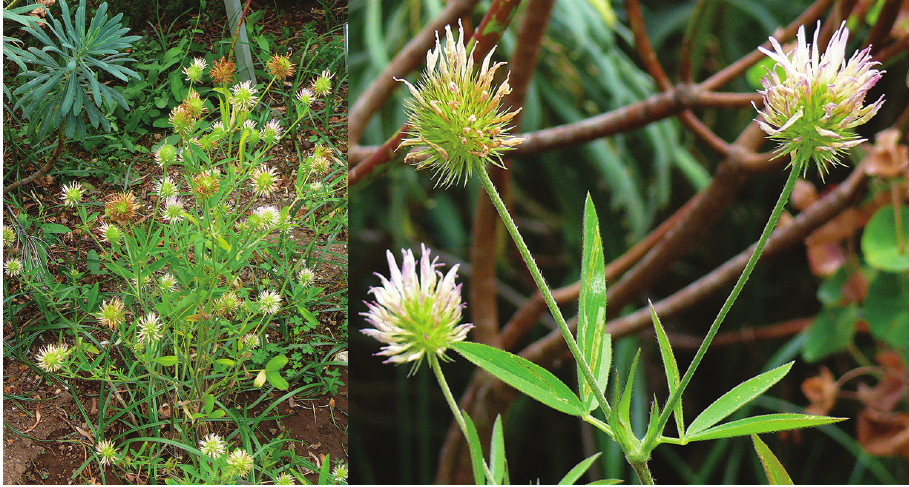
Figure 5. Trifolium latinum photographed in the Decima-Malafede Regional Park (Rome, Italy). Picutre by C.